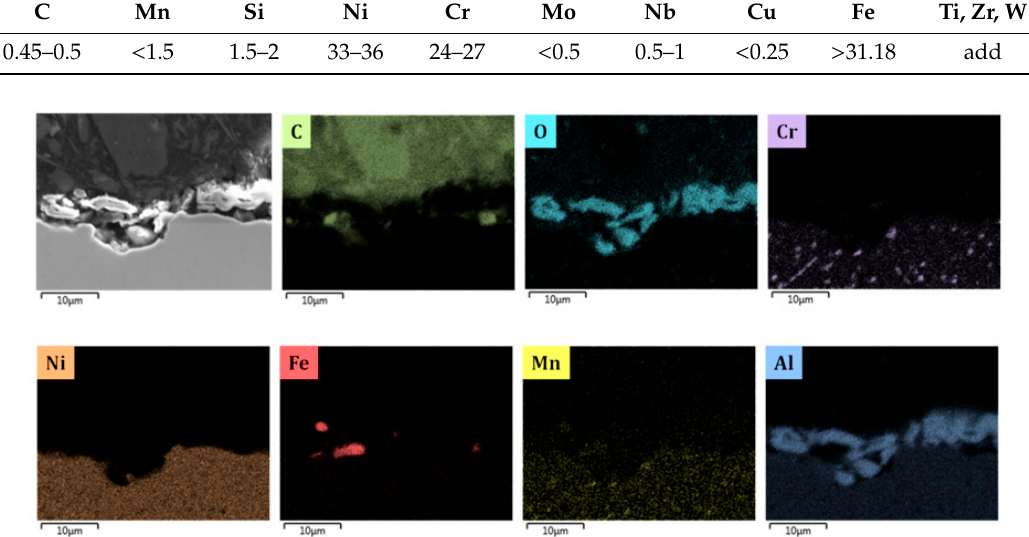
Table 1. Composition of the reference alloy [47].